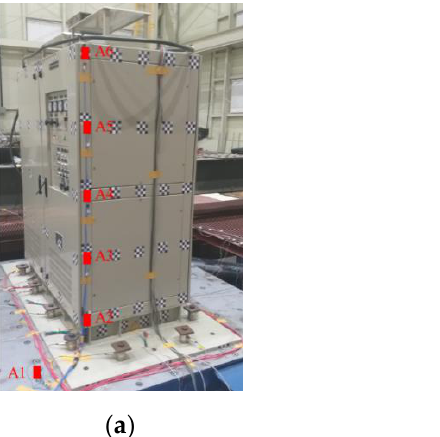
Figure 2. Location of installed accelerometers: ( a ) in-structure cabinet and ( b ) in-cabinet response.